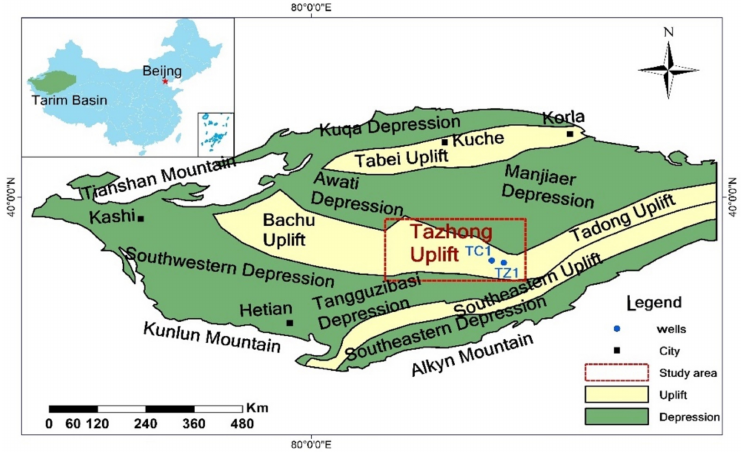
Figure 1. Geological structures of the Tarim Basin and the location of wells TC1 and TZ1 (modified from Gao, et al. (2018) [38]).